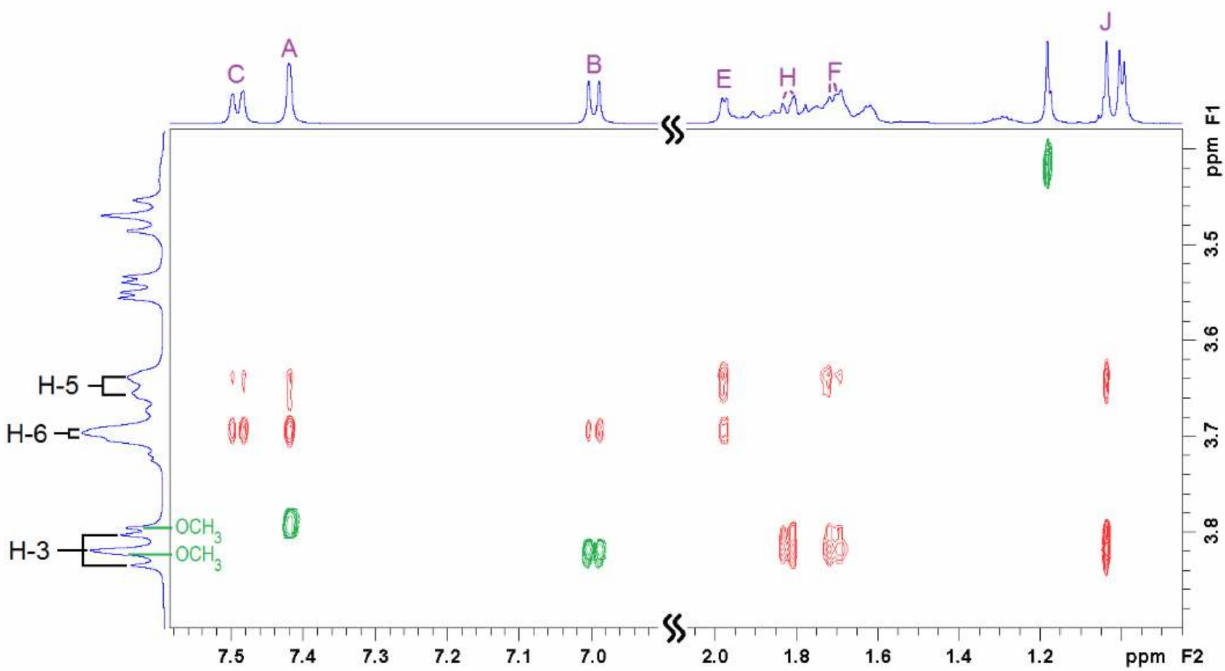
Figure 6. Two-dimensional ROESY NMR spectrum of the 1:1 VTD: γ -CD inclusion complex showing intermolecular ( red ) and intramolecular ( green ) cross-peaks. See Figure 1a,c for atom